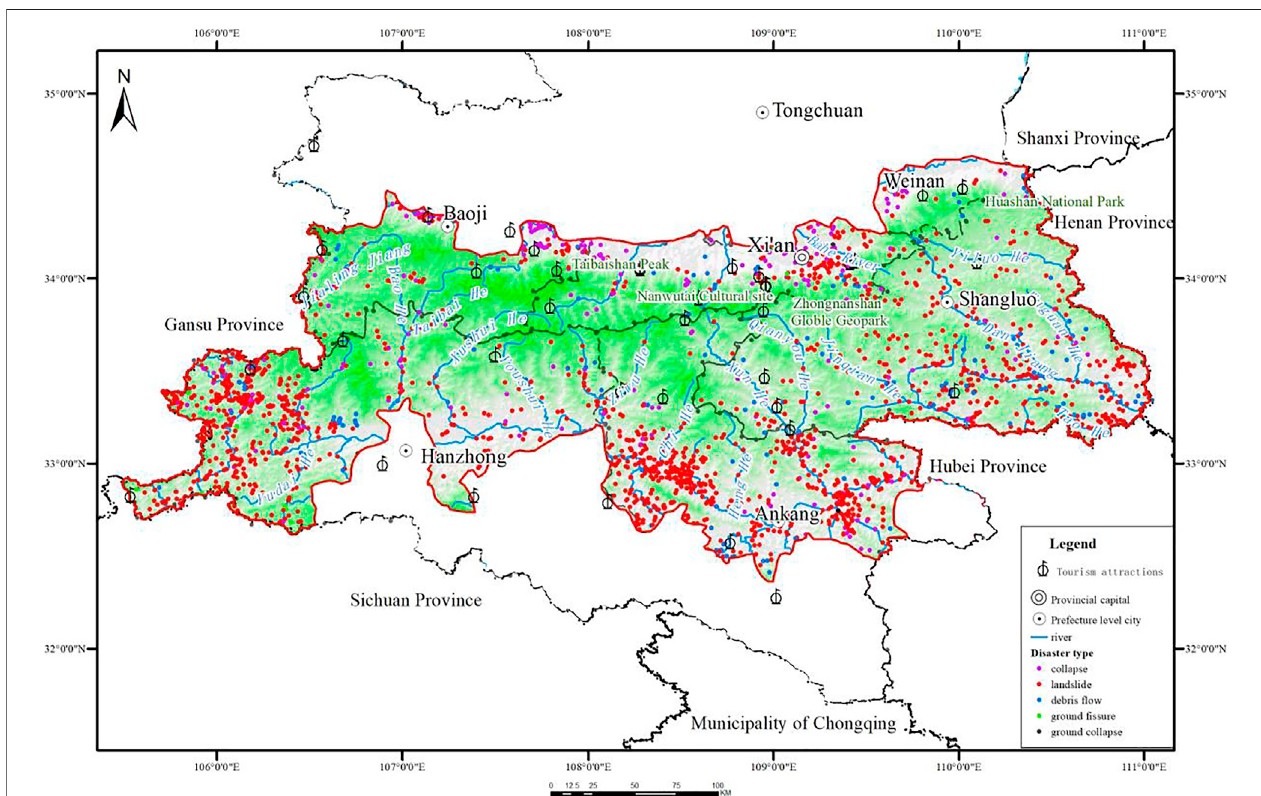
FIGURE 2 | Location of the study